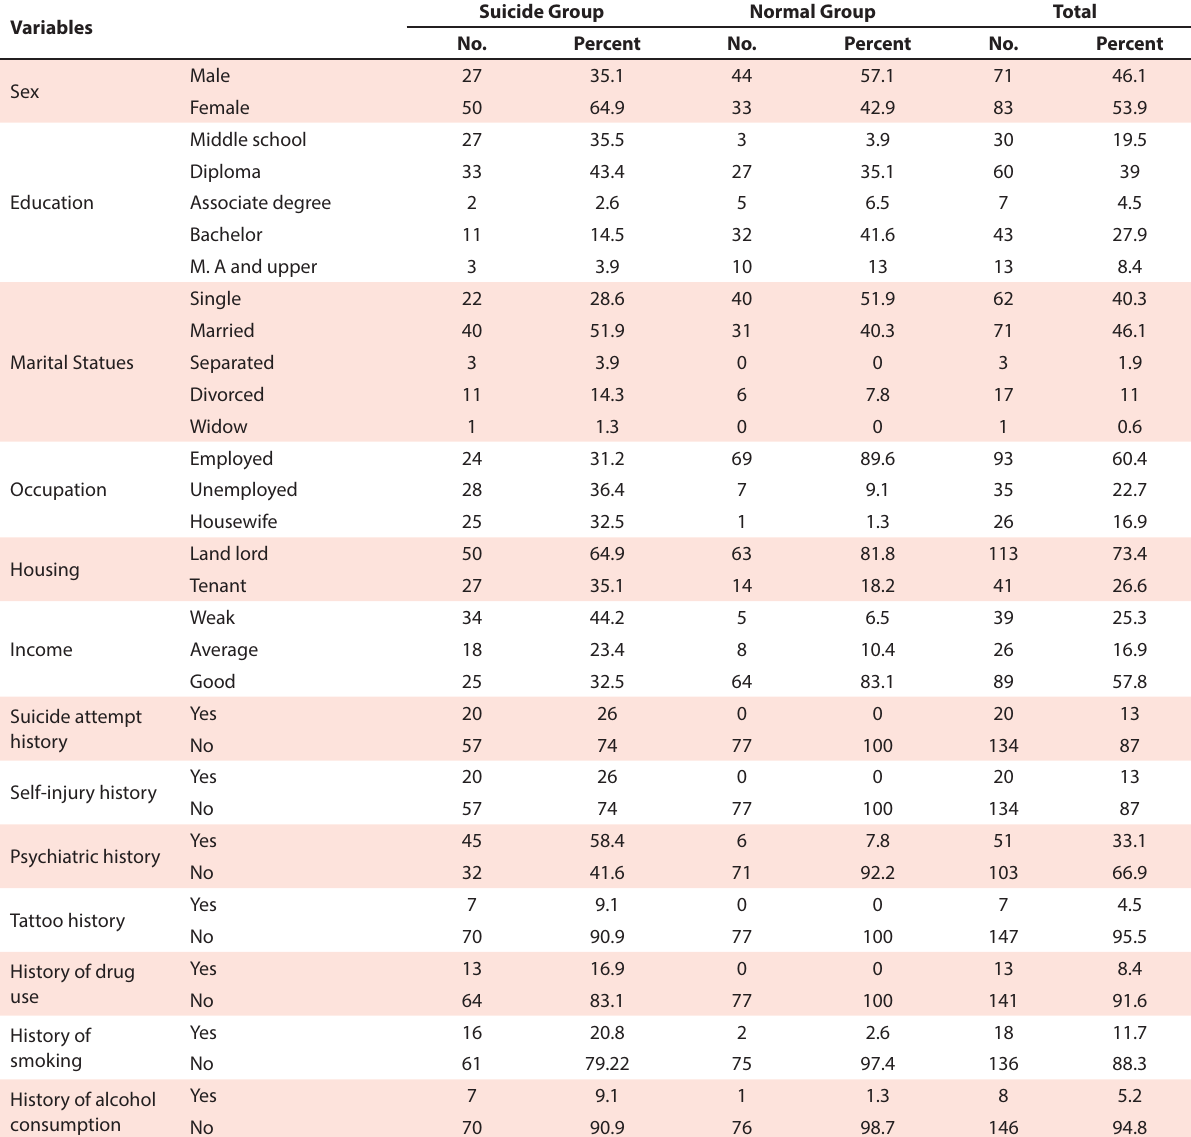
Table 1. Descriptive statistics of demographic